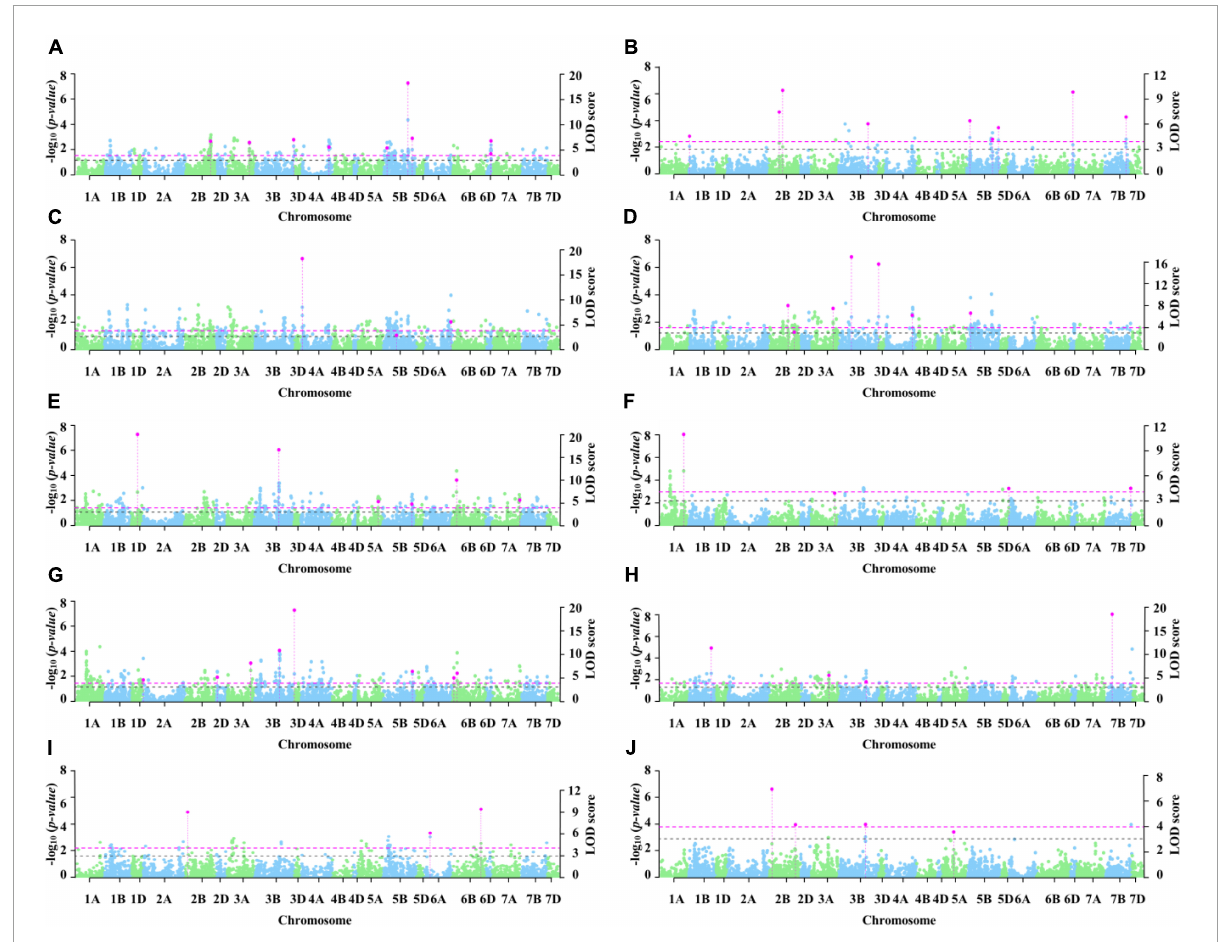
FIGURE3 Manhattan plot of significant loci for coleoptile length. The left y axis reports -log 10 ( p -values), which are obtained from single-marker genome-wide scanning for all the markers in the first step of 3VmrMLM, and the right y axis reports LOD scores, which are obtained from a likelihood ratio test for significant and suggested QTL in the second step of 3VmrMLM. In the Manhattan plots, the dashed pink line represents the threshold LOD = 3.99 and the dashed black line represents the threshold LOD = 3.0 ( A–J represent E 1 , E 2 , E 3 , E 4 , E 5 , E 6 , E 7 , E 8 , E 9 , and E 10 ,